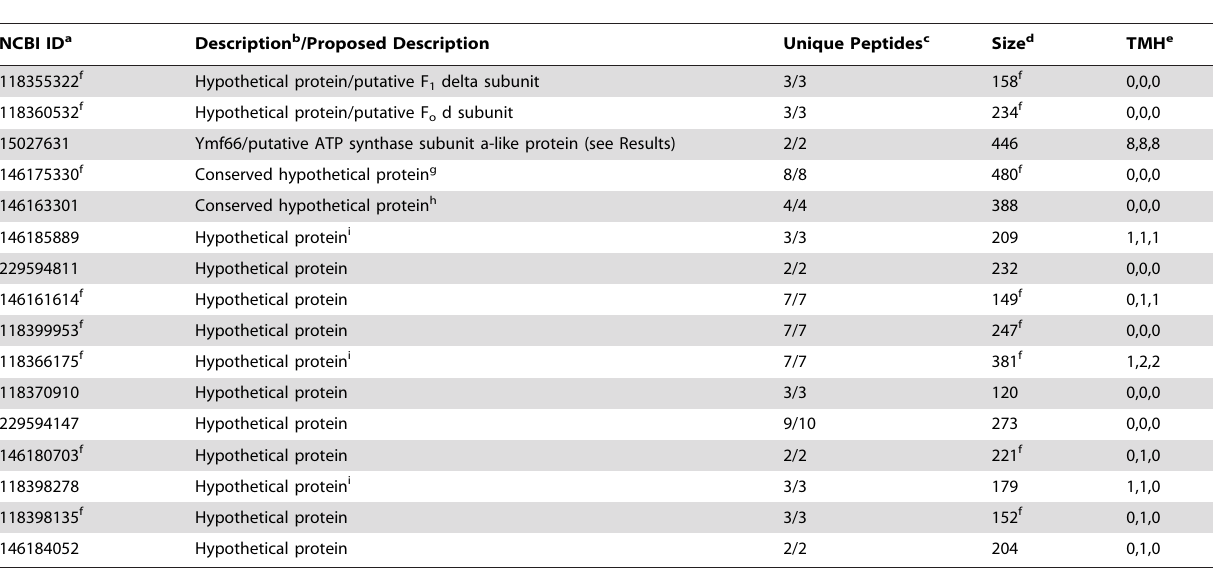
Table 2. Unassigned proteins detected in BN-PAGE spot 1 by LC/MS/MS.